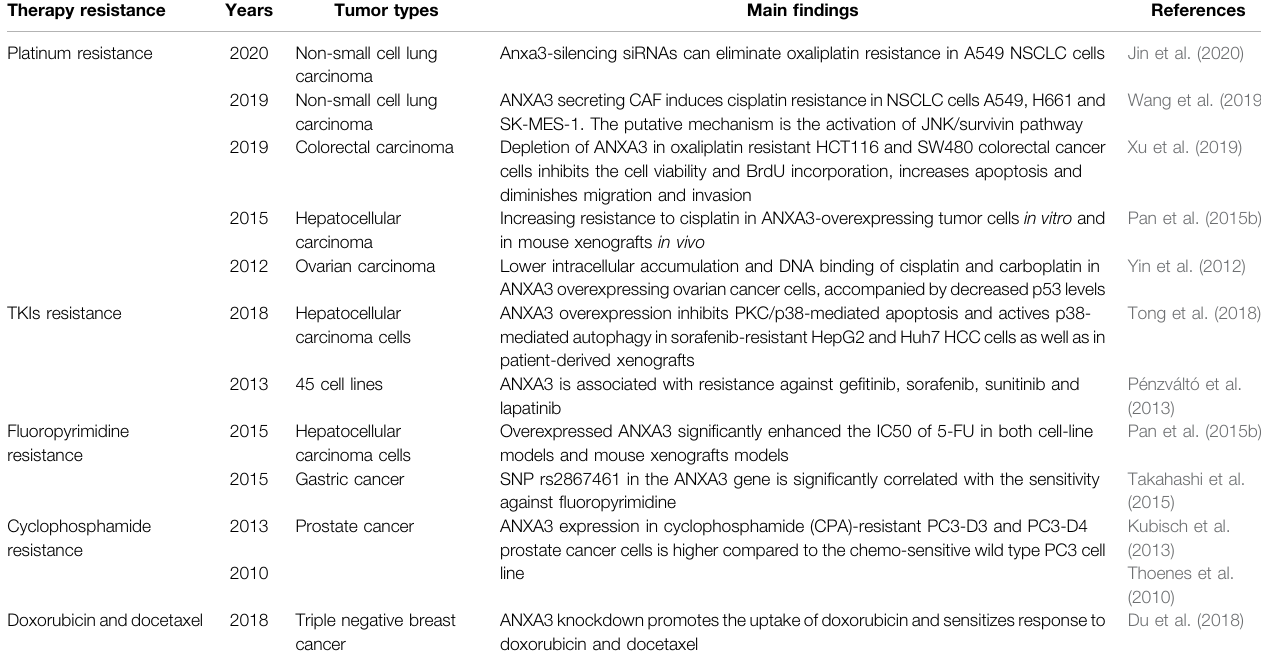
TABLE 2 | The role of ANXA3 in therapy resistance. Therapy